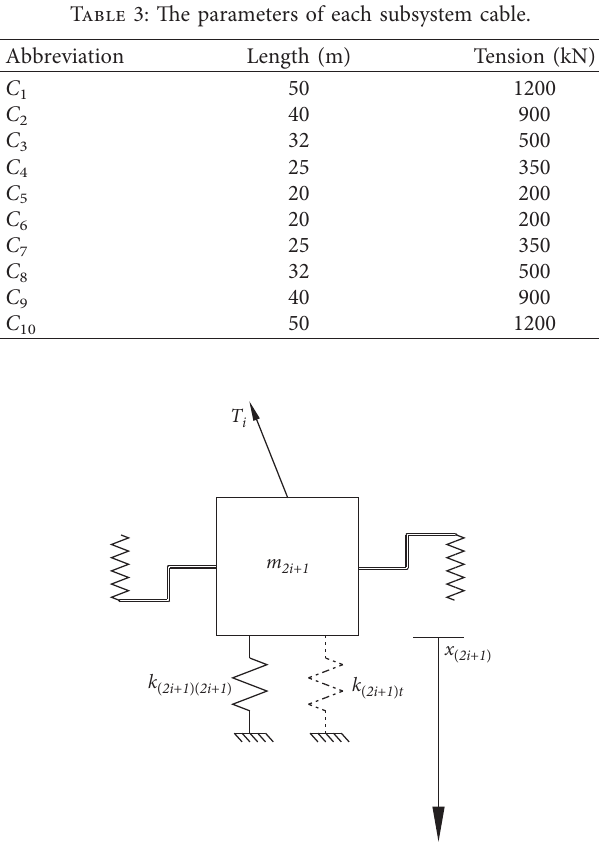
Figure 9: Excitation action decomposition of beam portion in one single